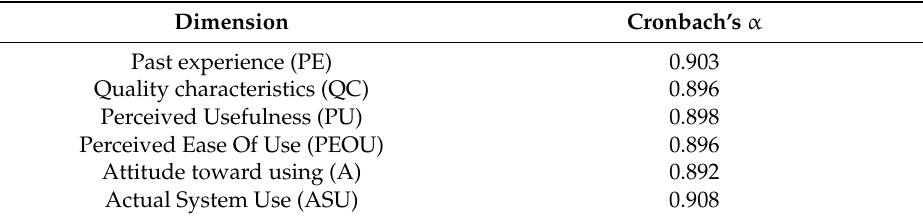
Table 2. Reliability coefficient of perceptions in each